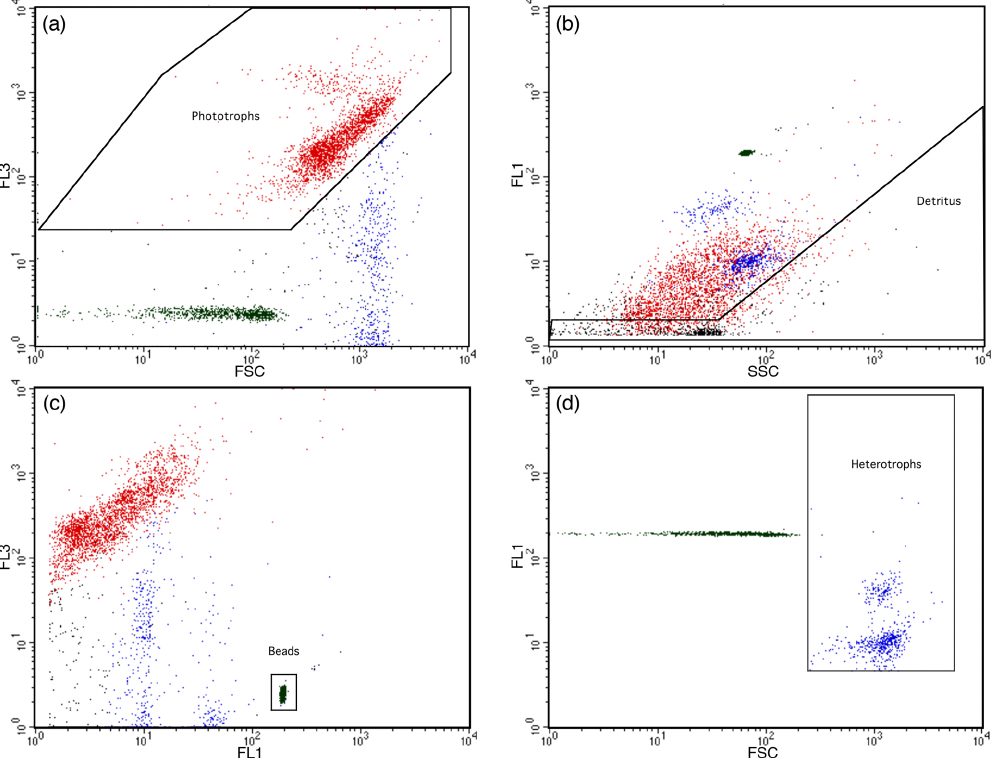
Figure 2. LysoTracker-Green-stained heterotrophic nanoflagellates identified by flow cytometry. (a) Phytoplankton identified based on red (FL3) versus forward-scatter (FSC) fluorescence scatter plots. (b) Detritus particles identified from high side scatter (SSC) versus Lyso- Tracker Green fluorescence (FL1). (c) PeakFlow Green 2.5µm beads identified from high FL1 versus FL3 fluorescence. (d) Phytoplankton and detritus from panels (a) and (b) removed from the FL1 and FSC plots and remaining LysoTracker-Green-stained particles > 2 . 5µm were counted as heterotrophic nanoflagellates.